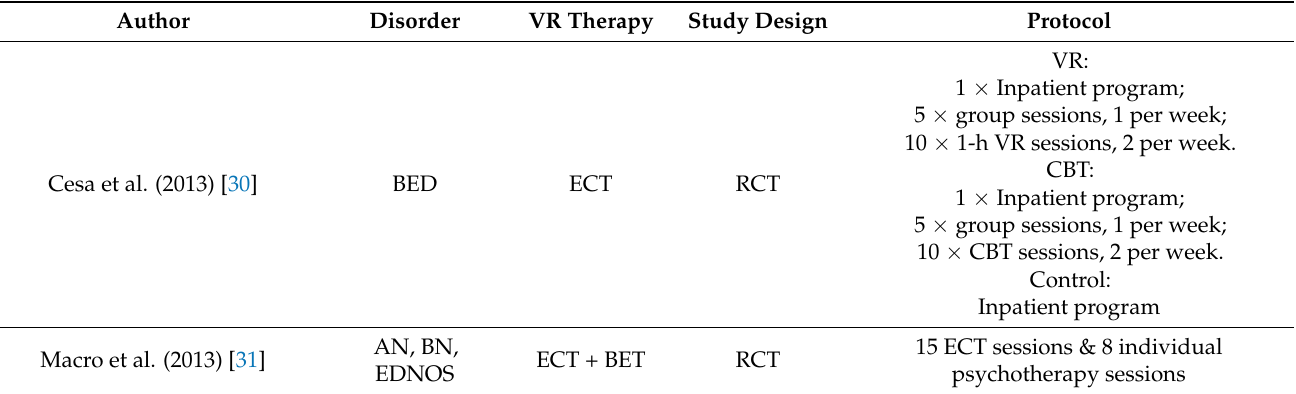
Table 5. Healthcare application in reviewed